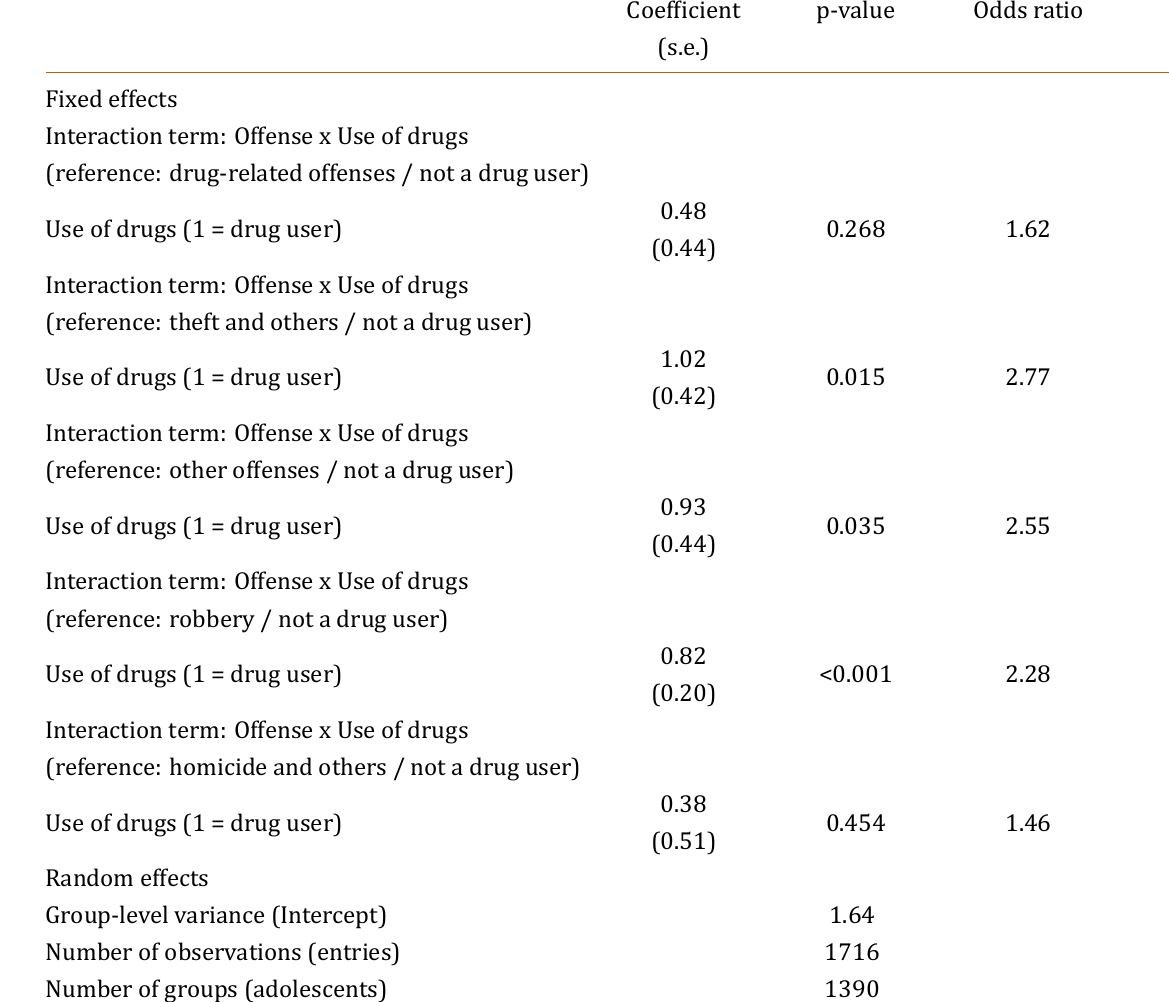
Table 4: Impact of seriousness of the offense on con(cid:976)inement among drug users and non-drug